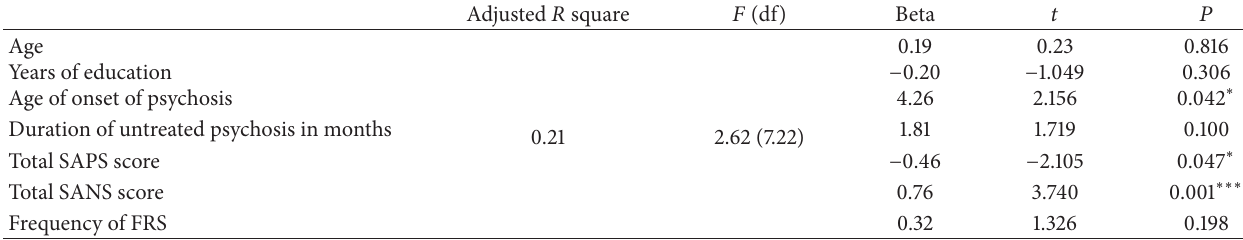
Table 6: Linear regression model of demographic and clinical variables of schizophrenia with and without first rank